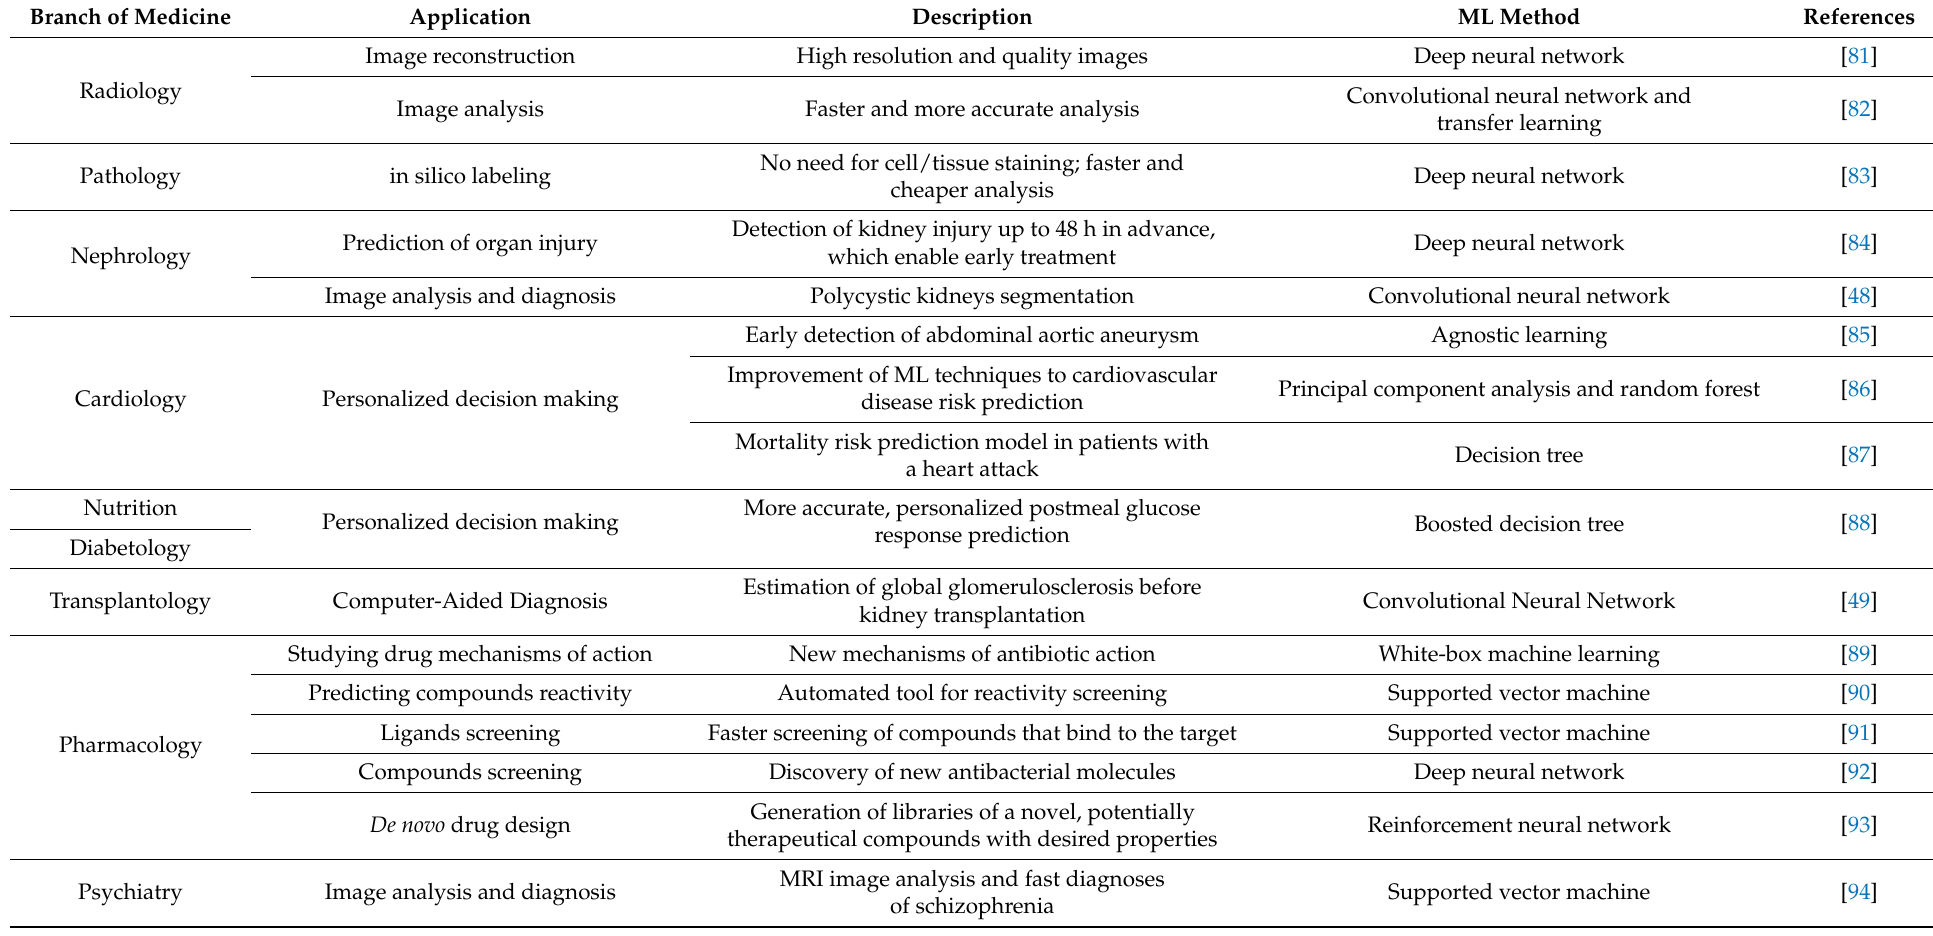
Table 3. Potential applications of machine learning in